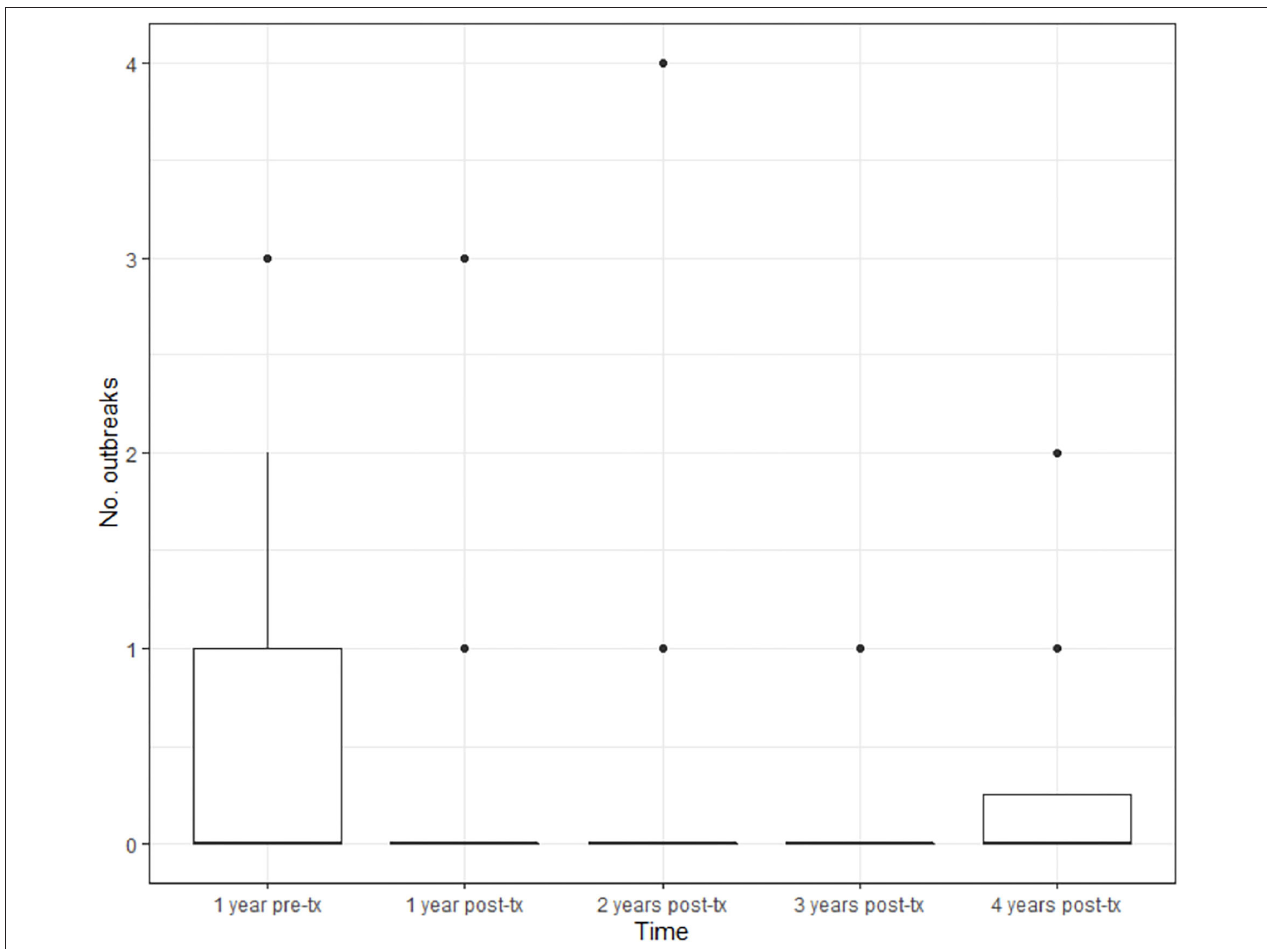
FIGURE 1 | Annual evolution of the relapse rate. BOX, Interquartile range; Groos line, medias; Dots, Extrem values ( > 1.5 × interquartile range) disability.